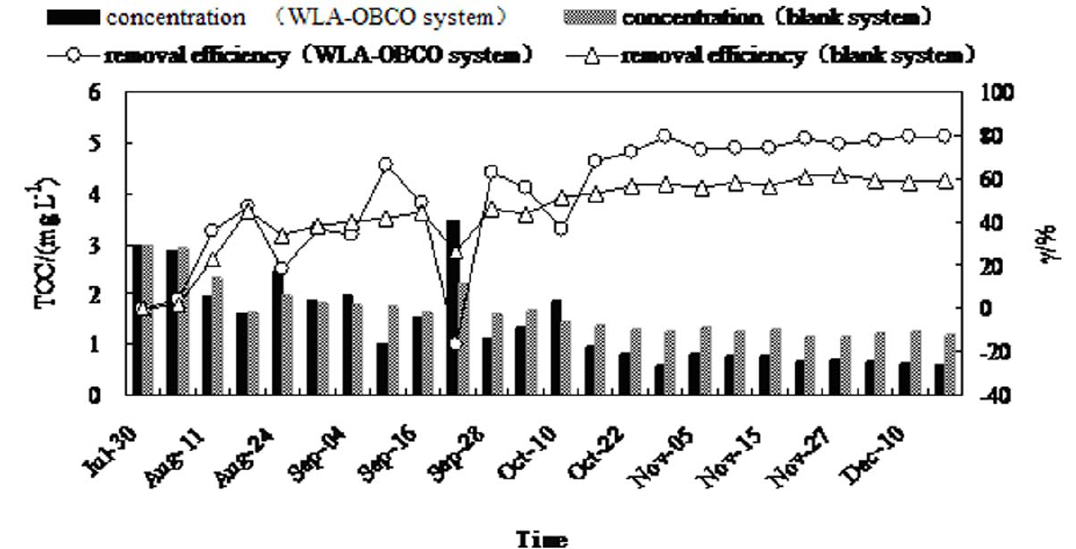
Figure 4. Variation of TOC concentration and removal efficiency during operation.